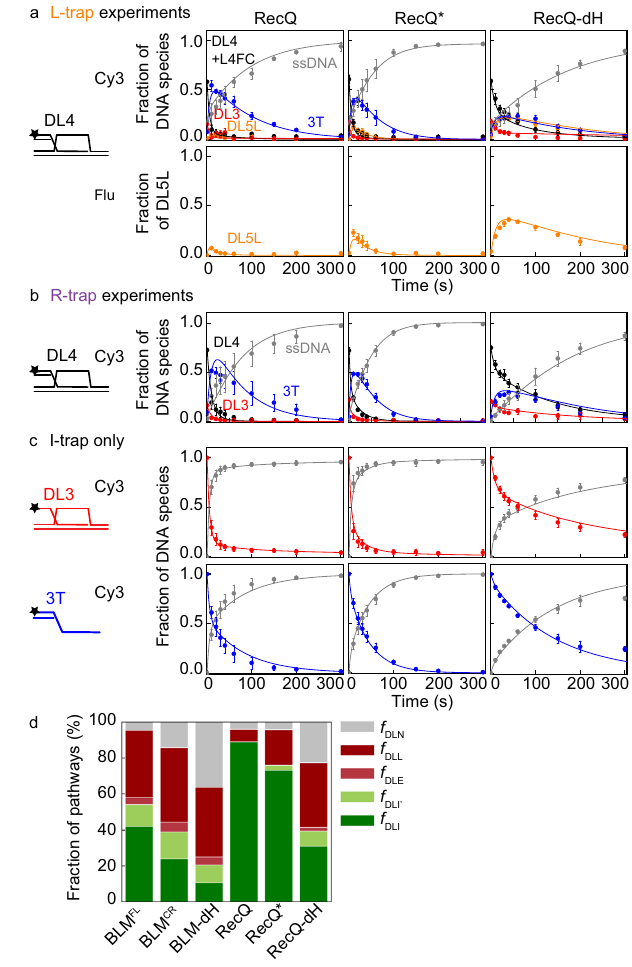
Fig. 7 Kinetics of D-loop processing by RecQ constructs. a , b Kinetic pro fi les of DL4 unwinding by RecQ, RecQ*, and RecQ-dH in the presence of ( a ) L-trap or ( b ) R-trap. The fraction of DL5L compared with initial DL4 was determined as in Fig. 6a. c Kinetic pro fi les of DL3 and 3T unwinding obtained in I-trap-only experiments. Data shown were replotted from Harami et al. 19 . Color coding of DNA species is as in Figs. 3, 5, and Supplementary Fig. 7: DL5L ( fi ve-stranded structure): orange, DL4 (4- stranded D-loop-like structure): black, DL3 (3-stranded D-loop-like structure): red, 3T (3 ′ -tailed dsDNA): blue, and ssDNA: gray. Solid lines show global best- fi ts of the model described in Supplementary Fig. 7 to all unwinding data (DL4, DL3 and 3T) of each enzyme variant. Means ± SEM ( n = 3) are shown on all panels for the detected fractions of DNA species at each time point determined from independent experiments with individual protein constructs. d Distributions of enzyme – DL (DL4 or DL3) con fi gurations (Fig. 3, Supplementary Fig. 7) obtained from global fi ts to the data shown in Figs. 6 and 7a – c. Con fi gurations leading to D-loop disruption are colored with green shades, whereas those leading to D-loop stabilization in an in vivo context are colored with shades of red. Nonproductive fractions are colored gray. Determined parameters are listed in Supplementary Table 2. Source data are provided as a Source Data fi